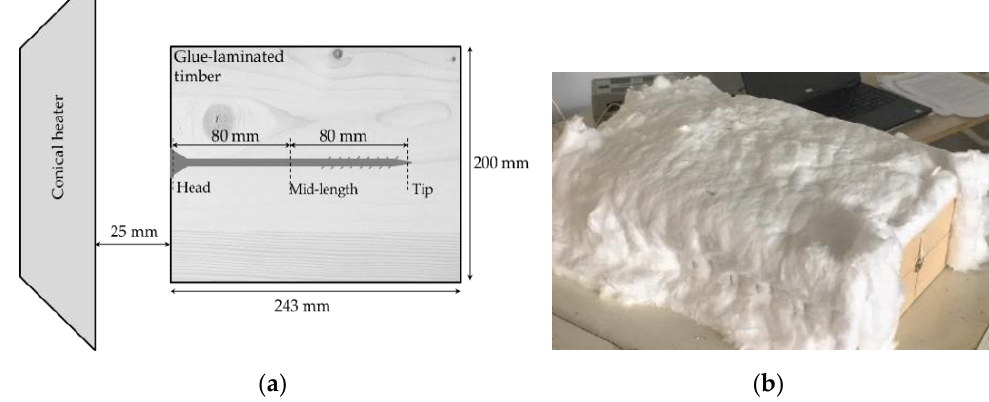
Figure 1. Thermocouples position for small-scale fire testing: ( a ) STS head exposed to fire without low-density refractory insulation; ( b ) STS head exposed to fire wrapped with low-density refractory insulation.